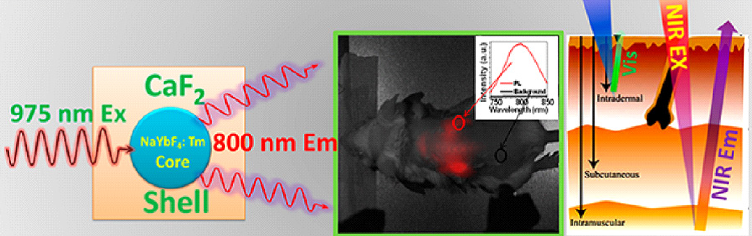
Figure 10. Example of lanthanide-doped UCNPs of core-shell structures with NIR-to-NIR optical transitions and their application for small animal imaging studies plus illustration showing the better penetration of NIR light in contrast with visible light. Reprinted with permission from [5]. Copyright American Chemical Society, 2012.